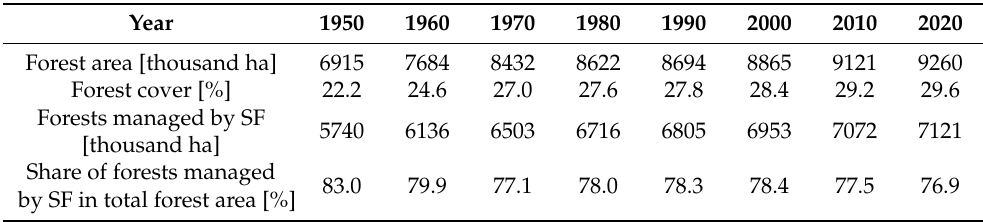
Table 1. The area of forests administered by SF as compared to all Poland’s forests *.